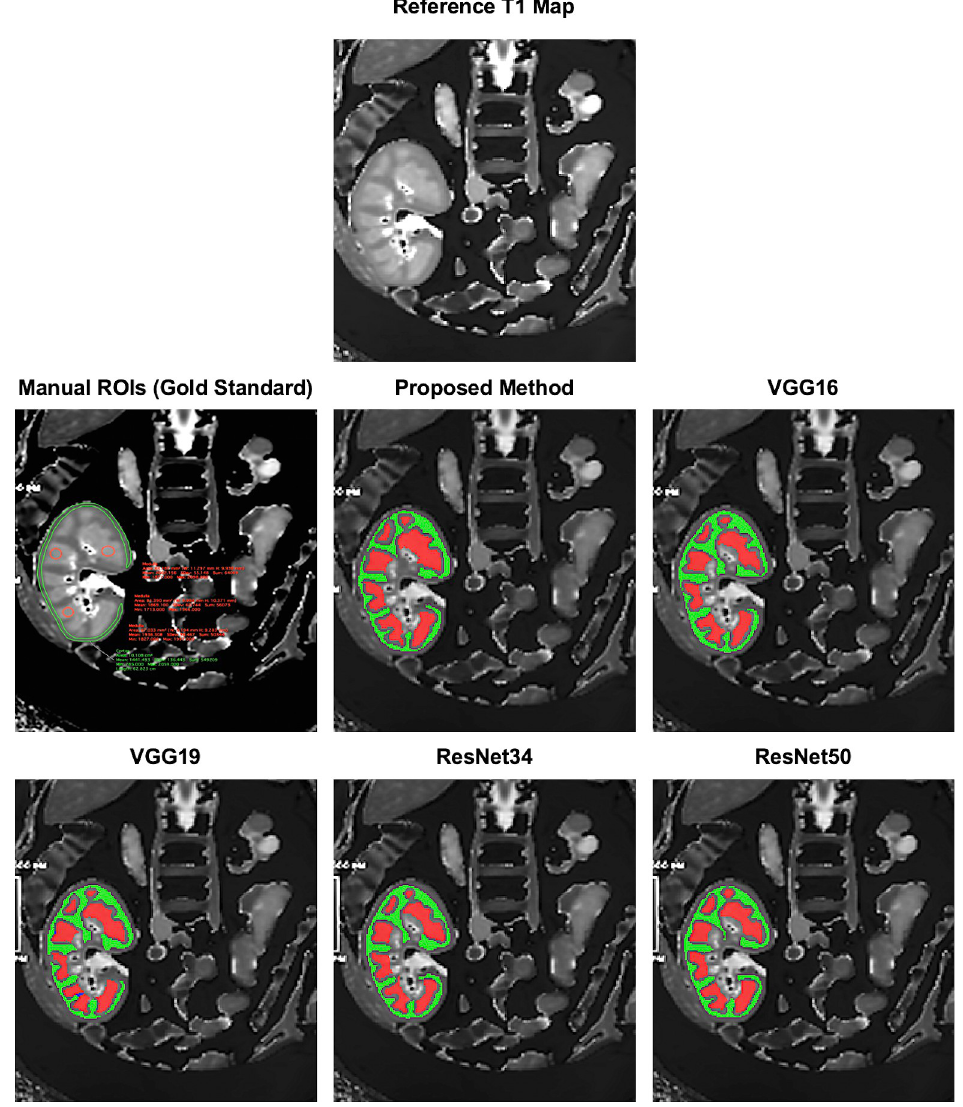
Fig 4. The gold standard manually drawn ROIs (hand drawn ROIs around cortex and medulla in Horos) and the deep-learning predicted masks after erosion (Green: Cortex, Red: Medulla, Blue: Segmentation leakage) over an allograft kidney patient T1 map to compute the cortico-medullary values. ROI erosion was performed to strongly match the hand-drawn gold standard ROIs. Also, ROI erosion was used to avoid the mixed portion of both cortex and medulla (segmentation leakage) to compute the cortico-Medullary